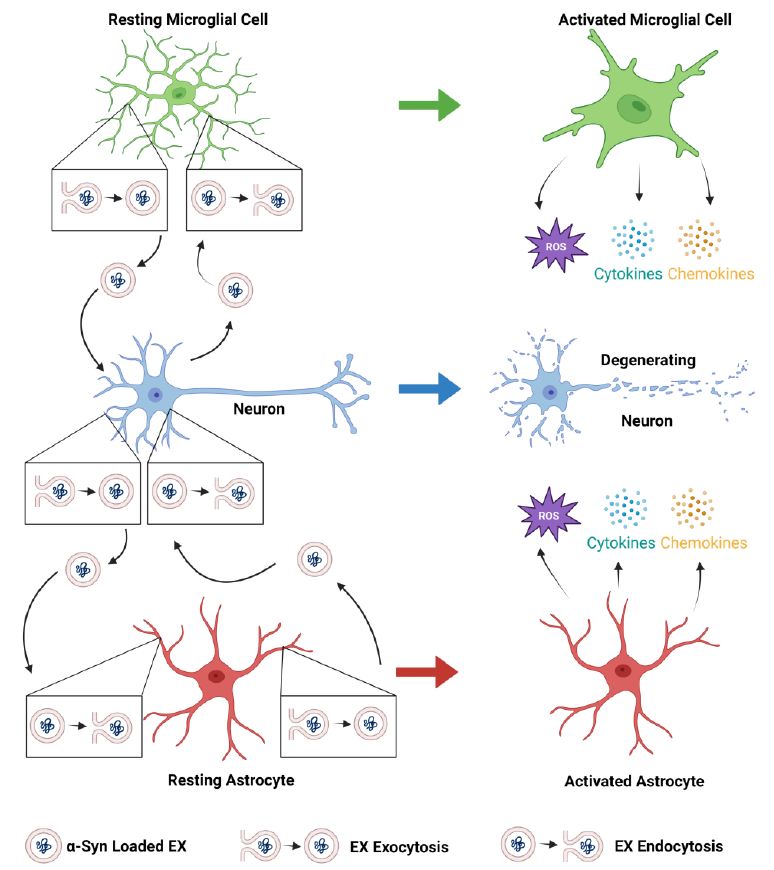
Figure 1. The transfer of α-syn to and from neurons, astrocytes, and microglia. The transfer of α-syn to astrocytes and microglia results in their activation. Activated astrocytes and microglia release ROS, pro-inflammatory cytokines and chemokines, which contribute to the neurodegenerative processes in PD. The figure was created with BioRender.com https://app.biorender.com/ (accessed on 24 March 2023).